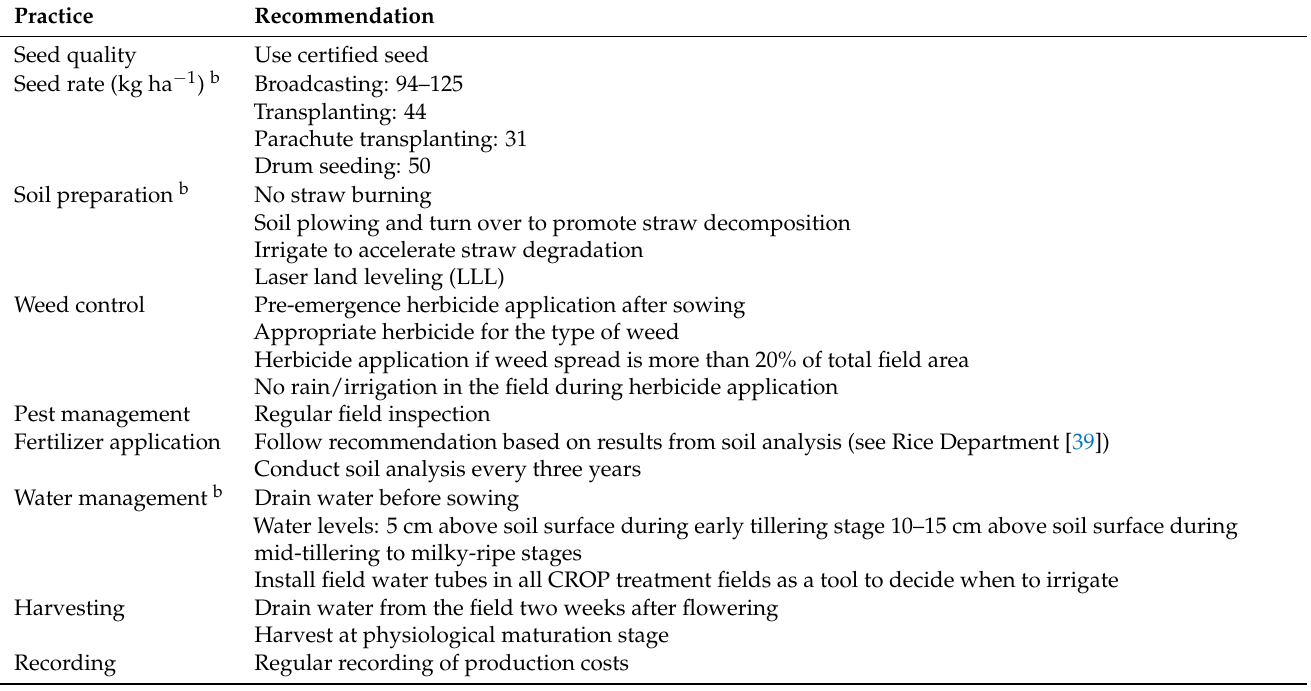
Table 2. Recommended practices based on the Cost Reduction Operating Principles (CROP) a